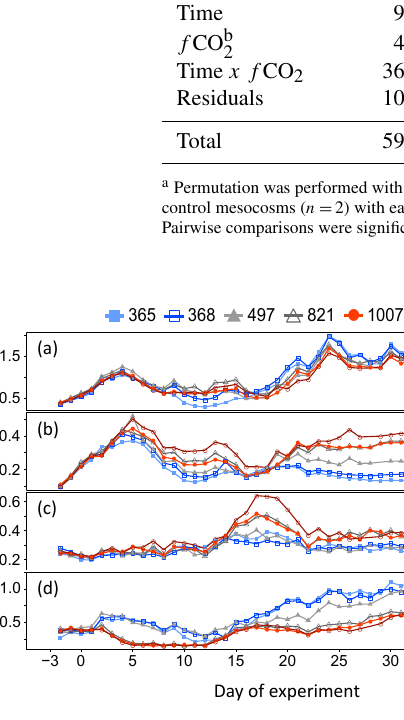
Figure 3. (a) Biovolume of Synechococcus spp. [ × 10 5 µm 3 mL − 1 ] and (b–d) biovolume of picoeukaryote groups I–III (Pico I-III) [ × 10 5 µm 3 mL − 1 ] during the course of the experiment. Colours and symbols indicate average f CO 2 [µatm] between t 1 and t 43.